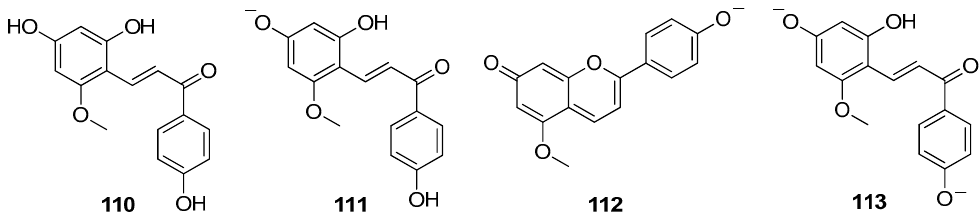
Figure 18. Species 110 – 113 in equilibrium with dracoflavilium ( 107 / 108 ) in aqueous solution at different pH. di ff erent different pH.